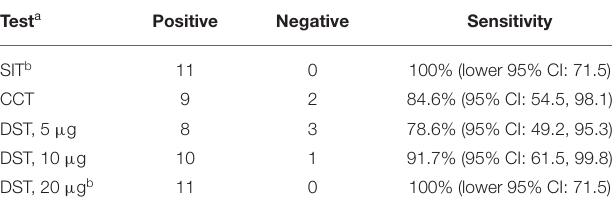
TABLE 1 | Relative sensitivities of SIT, CCT, and DST at different